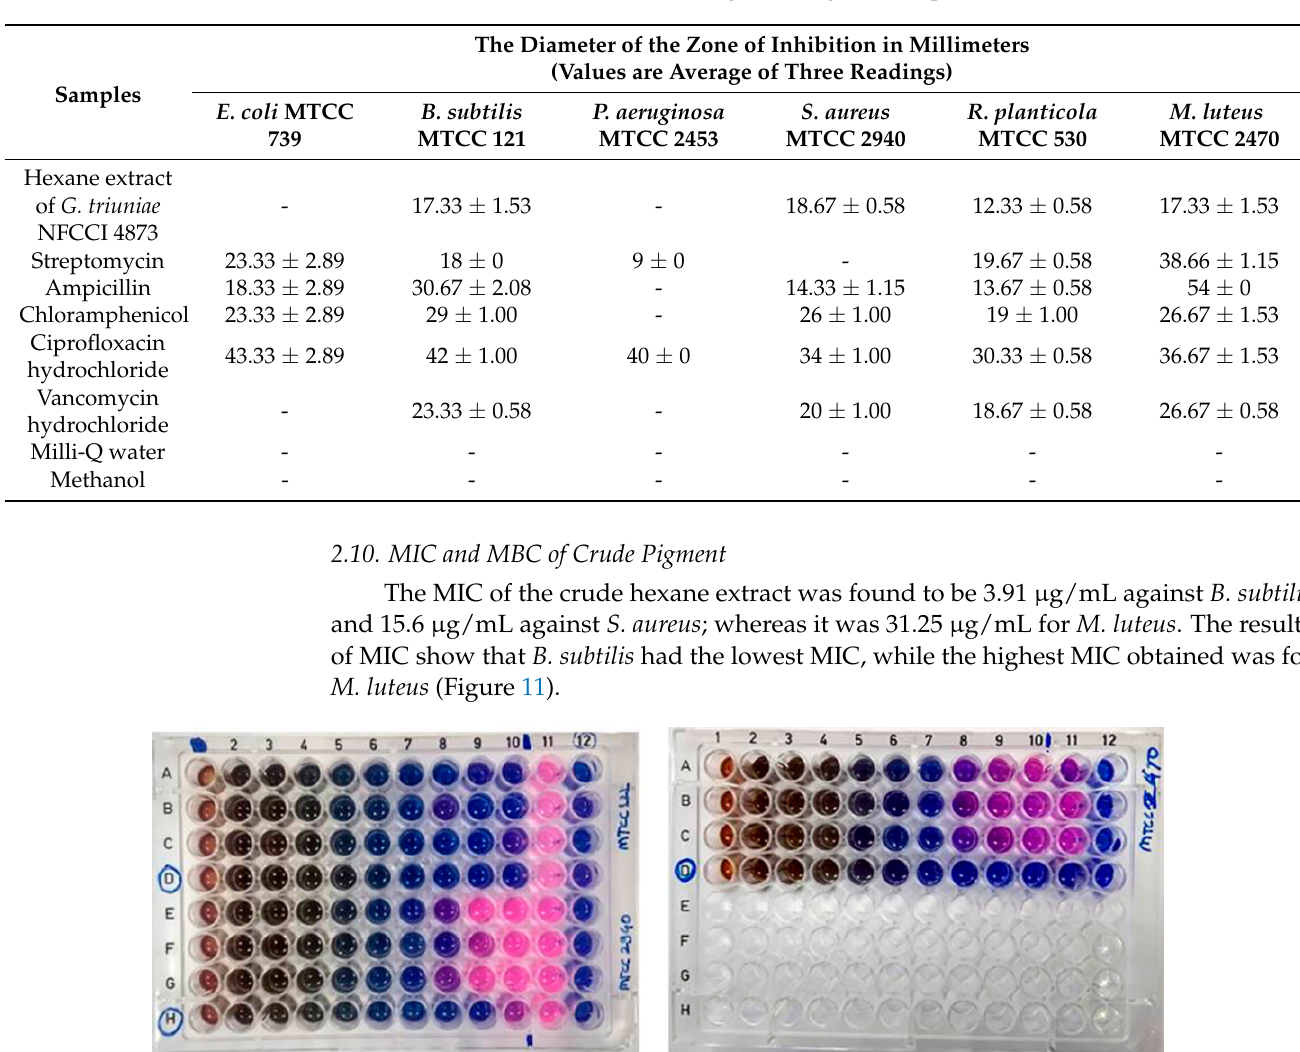
Samples Table 1. The zone of inhibition of test organisms against sample and standards with control.